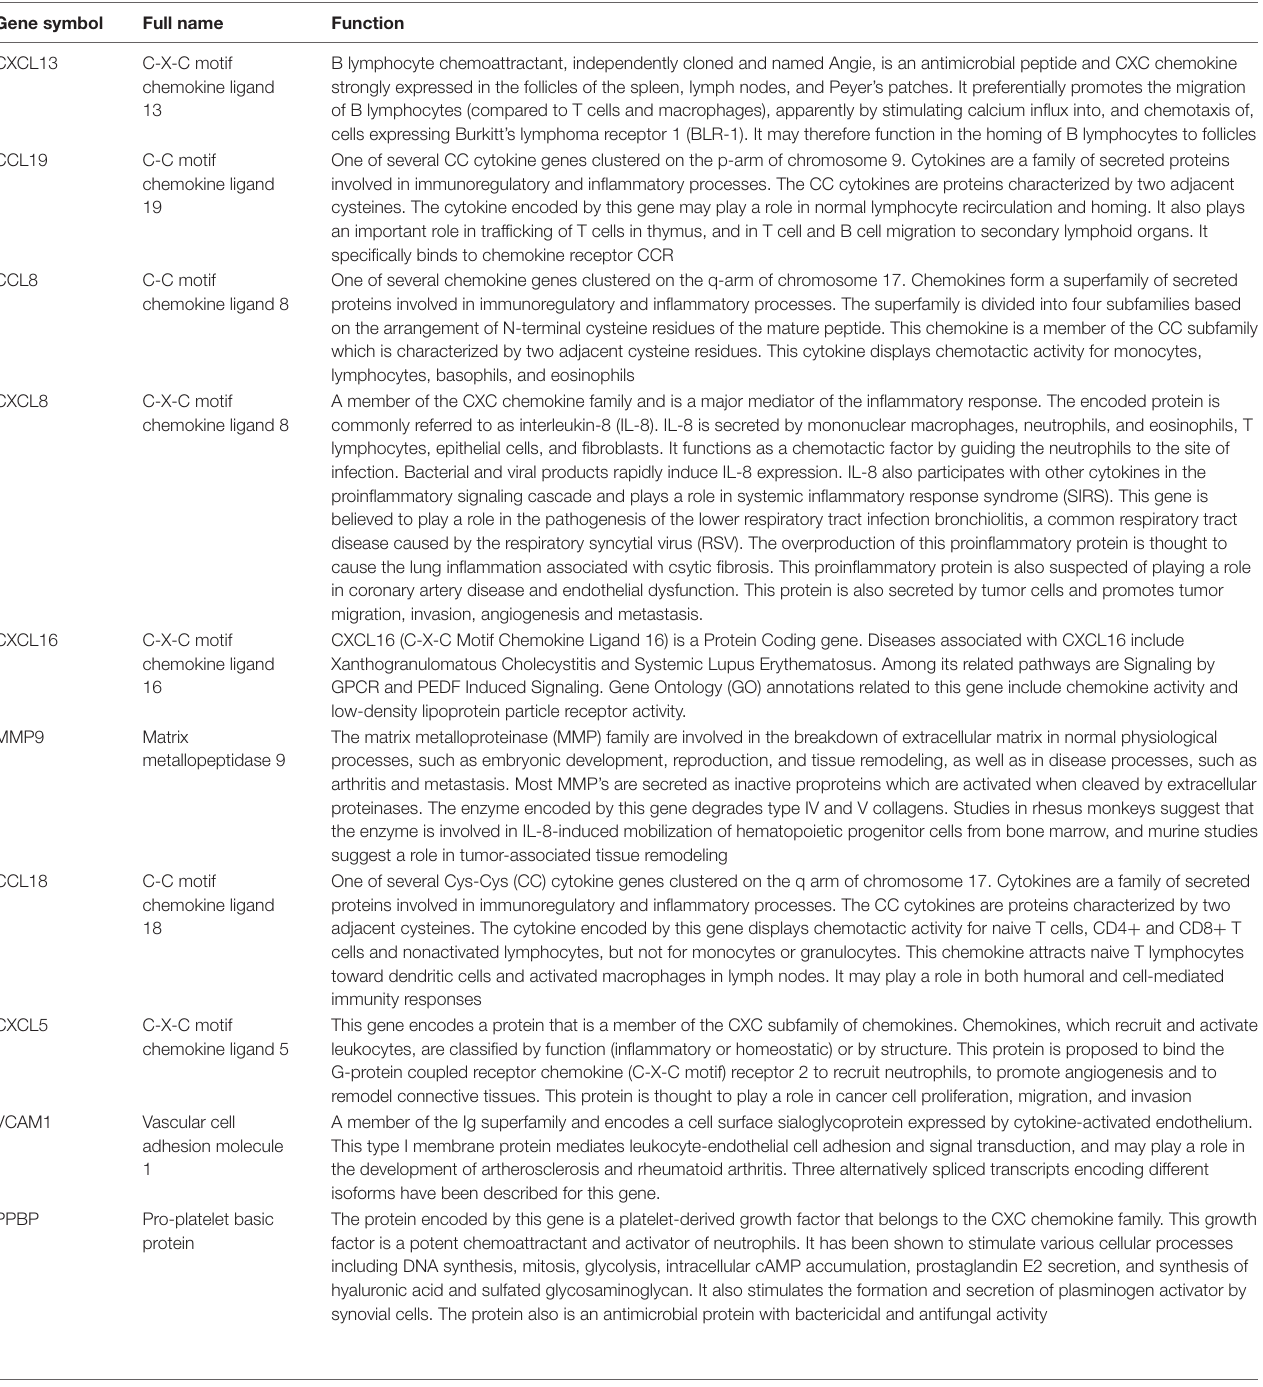
TABLE 3 | Summary of the function of 10 hub